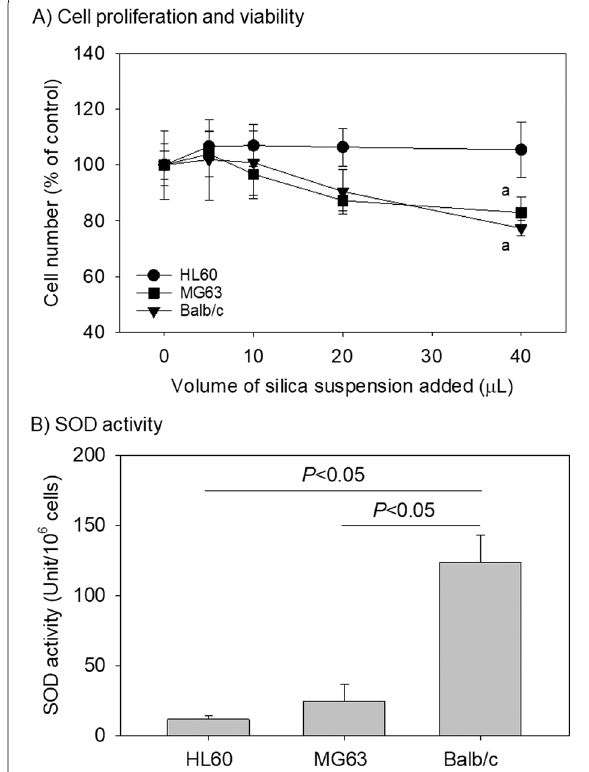
Fig. 1 Dose-dependent effects of silica microparticles on the proliferation A and the superoxide dismutase (SOD) activity B of HL60, MG63, and Balb/c cells. n 4 A and n 5 B in independent = = cultures. The raw cell numbers at 100% represent 7.49 9.84 10 5 ± × (HL60), 2.68 0.16 10 5 (MG63), and 3.09 0.33 10 5 /dish (Balb/c), ± × ± × respectively. a P < 0.05 represents a significant difference from the respective controls, to which no silica suspension was